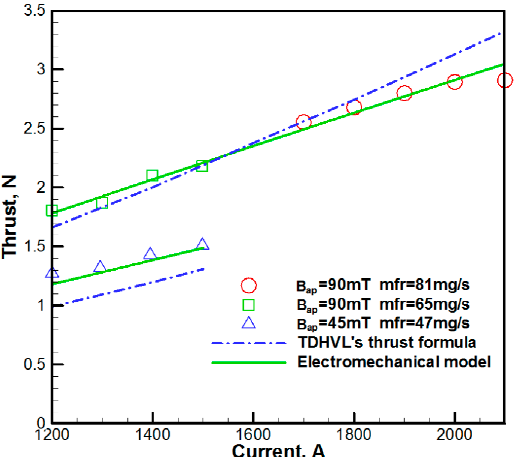
Figure 6. Variations of theoretical and experimental thrust with currents. Energies 2019 , 12 , x FOR PEER REVIEW